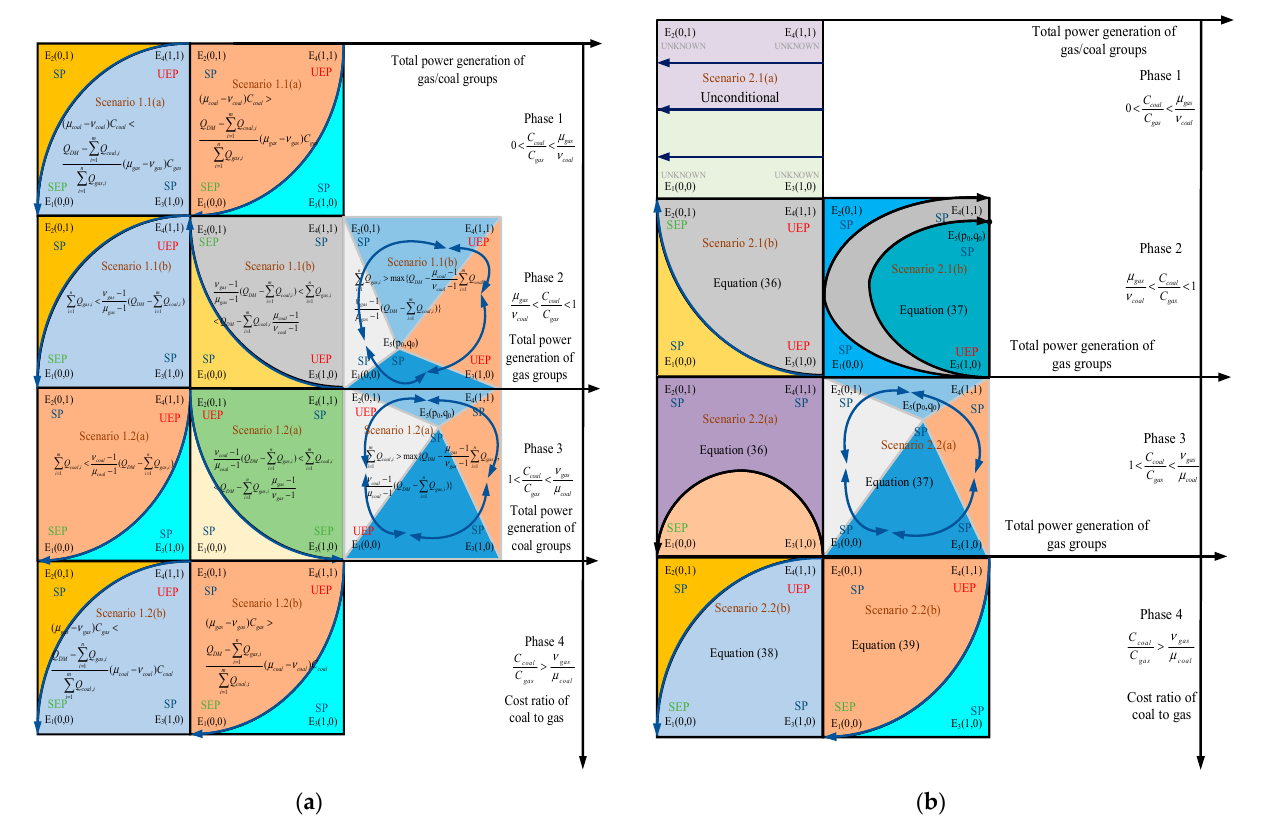
Figure 2. The evolution trend of bidding strategies of power generation groups. ( a ) The evolution trend in scenario 1, ( b ) The evolution trend in scenario 2.